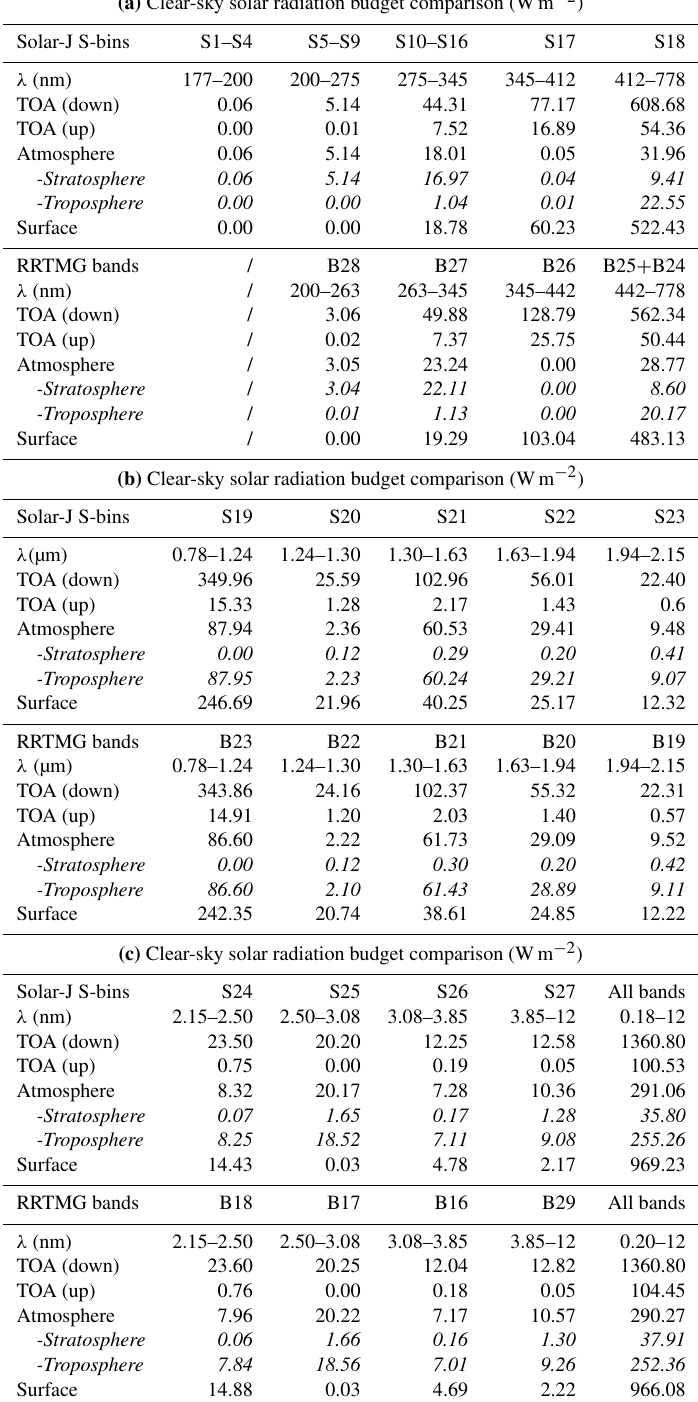
Table 4. Spectral shortwave radiation energy budget in Wm − 2 under clear aerosol-free July tropical conditions: Solar-J versus RRTMG. The solar constant is set at 1360.8Wm − 2 . For easy comparison, some Solar-J bins are combined to best match RRTMG’s band of similar range and vice versa. Note that the atmospheric absorption is further split into the stratospheric and tropospheric components (see numbers in